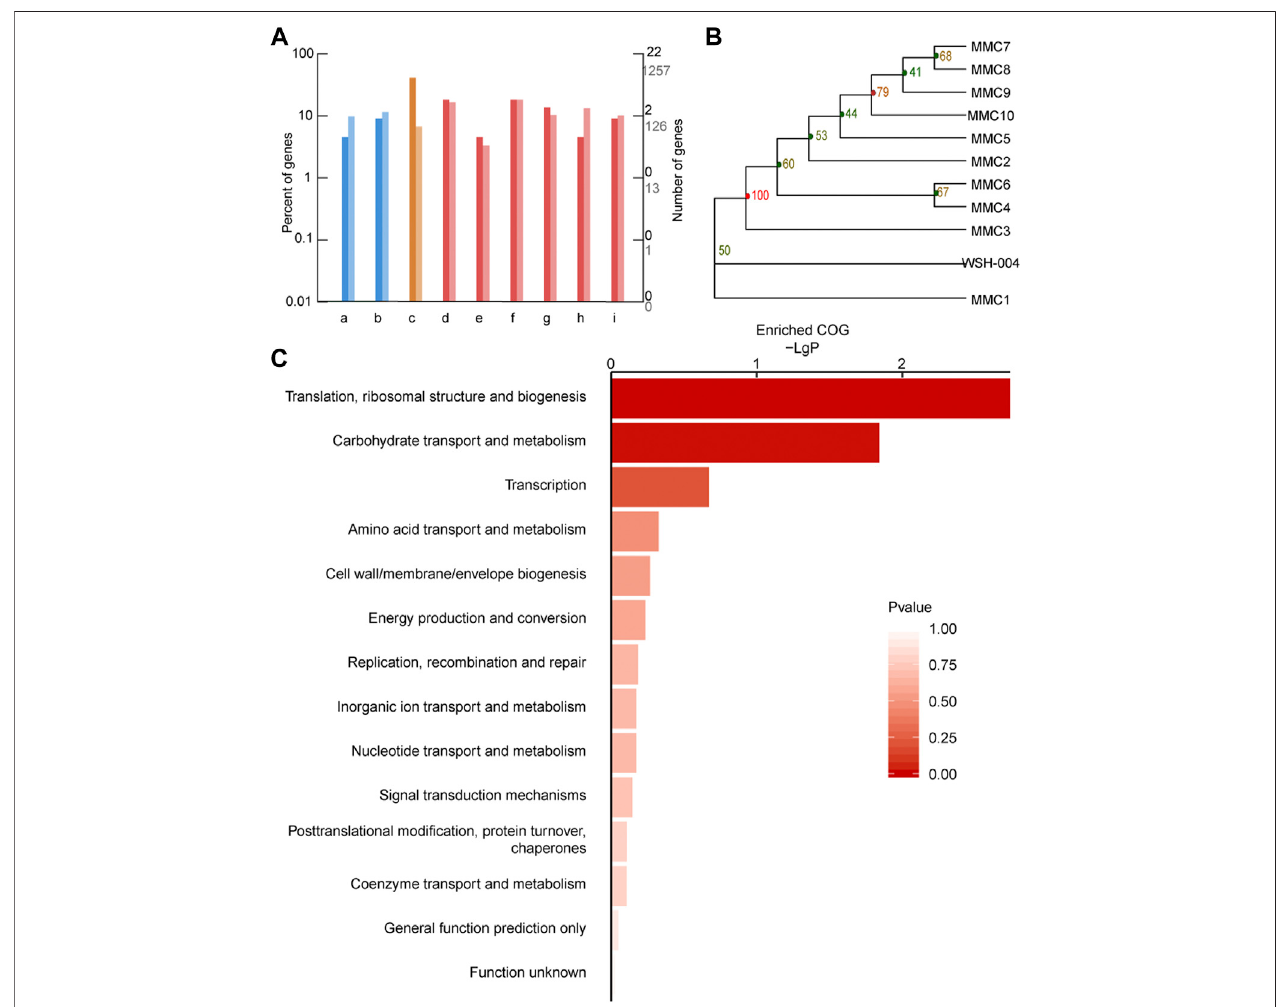
FIGURE8| Comparativegenomicanalysisof G.oxydans strains. (A) GOannotationclassi fi cationcolumnmapofvariantgenes.Thehorizontalaxisisthefunctional classi fi cation, and the vertical axis is the number of genes in the classi fi cation (right) and the percentage of the total number of genes on the annotation (left) . Different colors represent different categories. The dark color on the histogram and the axis represents the variant gene, and the light color represents all genes (background genes). (i)Membrane transport, (ii) signal transduction, (iii)translation,(iv) amino acidmetabolism,(v) biosynthesisofothersecondarymetabolites, (vi)carbohydrate metabolism, (vii) energy metabolism, (viii) metabolism of cofactors and vitamins, and (i) nucleotide metabolism. (B) Phylogenetic tree of a series of adaptive evolution strains. G. oxydans phylogenetic tree based on the SNP of each sample. (C) Signi fi cant enrichment function bar chart. The vertical axis represents function annotation information, and the horizontal axis represents the degree of enrichment corresponding to the function, that is, the − log10 ( p value) value. The higher the enrichment degree, the longer the column and the darker the color.